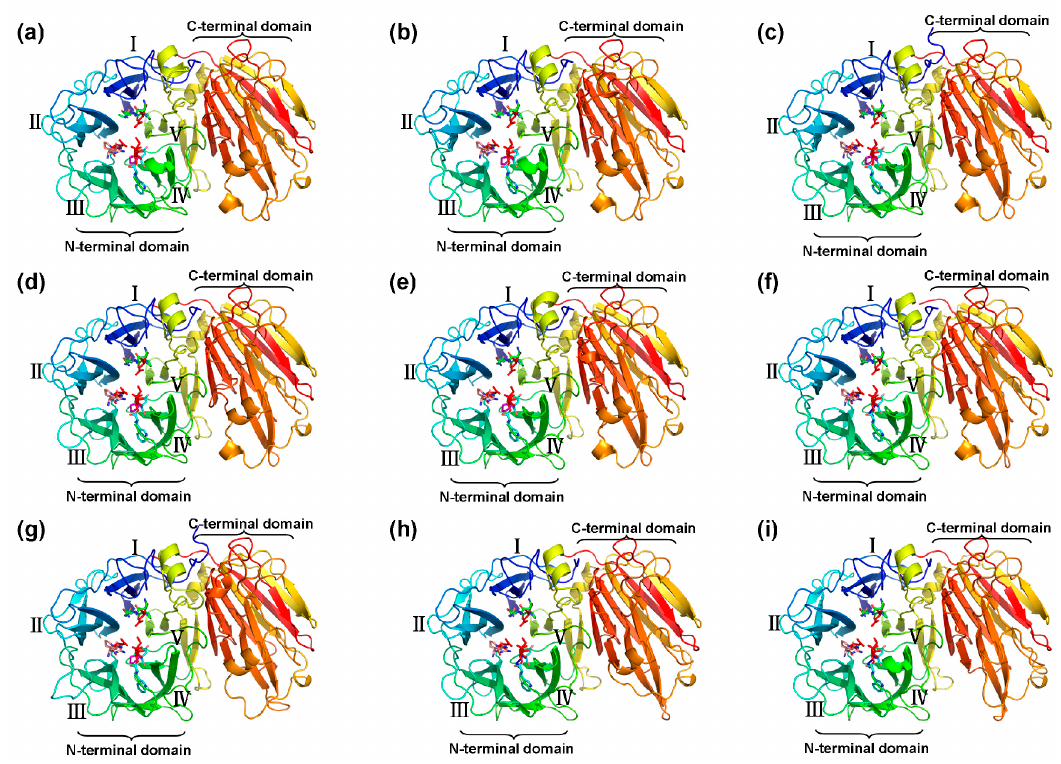
Figure 6. Predicted three-dimensional structure models of CaAINVs. ( a ) CaCWINV1; ( b ) CaCWINV2; ( c ) CaCWINV3; ( d ) CaCWINV4; ( e ) CaCWINV5; ( f ) CaCWINV6; ( g ) CaCWINV7; ( h ) CaVINV1; ( i